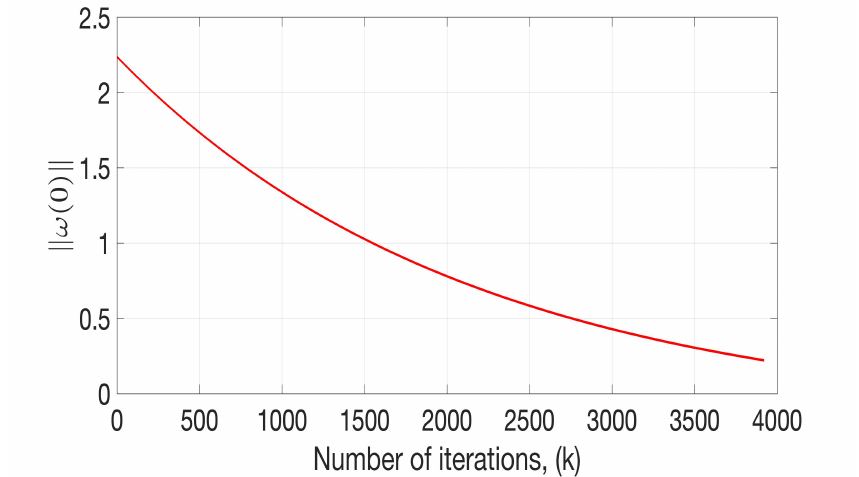
Figure 5. Recurrent evolution of the norm of the weights at the initial moment defined by the Kiefer–Wolfowitz